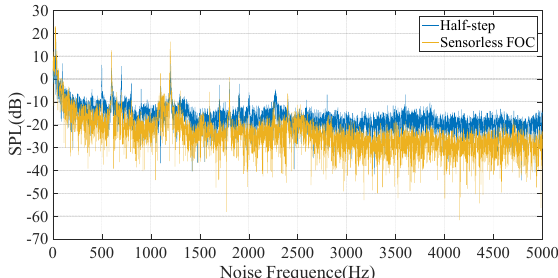
Figure 13. Testing result: the SPL spectrum of the motor at 120 rpm idle operation.